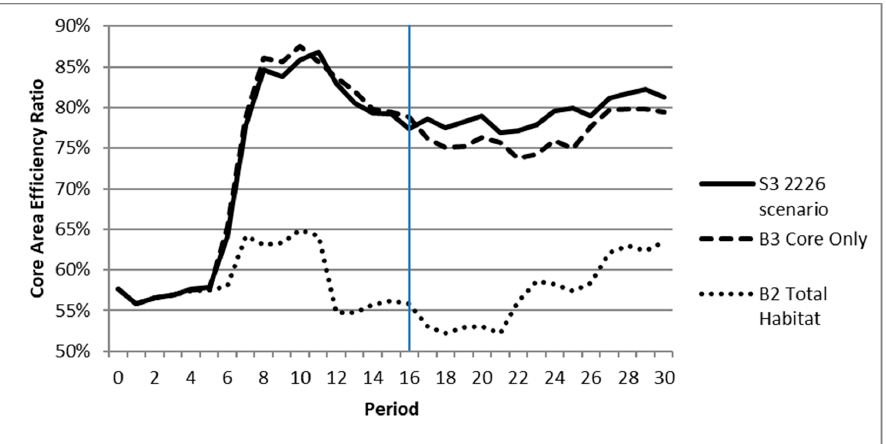
Figure 9. Core area efficiency ratios (CR) for the S3 2226 scenario and the B2 and B3 benchmark scenarios.